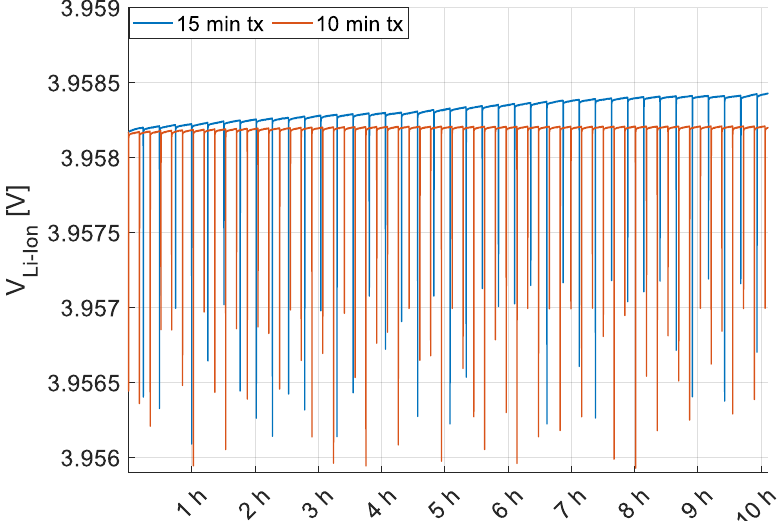
Figure 12. Li-Ion battery voltage behavior, V Li−Ion , during two tests lasting 10 h each and performed in the grid point (0, − 60,0) at the minimum level of illuminance (i.e., 410 lx). The blue plot corresponds to the case of radio transmissions every 15 min while the red plot refers to transmissions every 10 min.